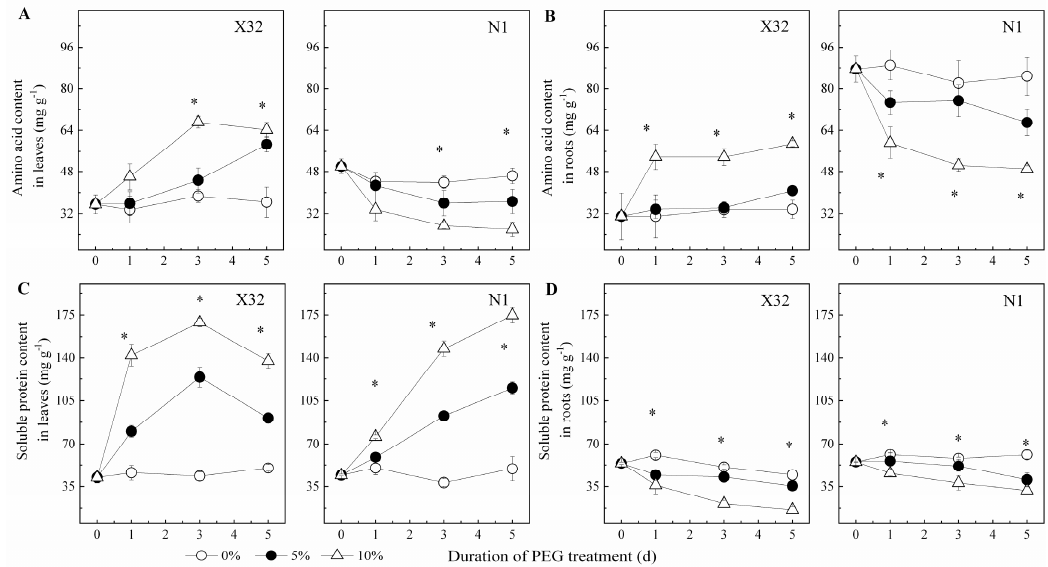
Figure 8. Effects of drought stress on amino acid and soluble protein content in leaves ( A , C ) and roots ( B , D ) of sweet potato. X32 and N1 represent Xushu 32 and Ningzishu 1, respectively. The stages labeled with an asterisk (*) indicate significant differences ( p < 0.05) among the three PEG levels in the figure.